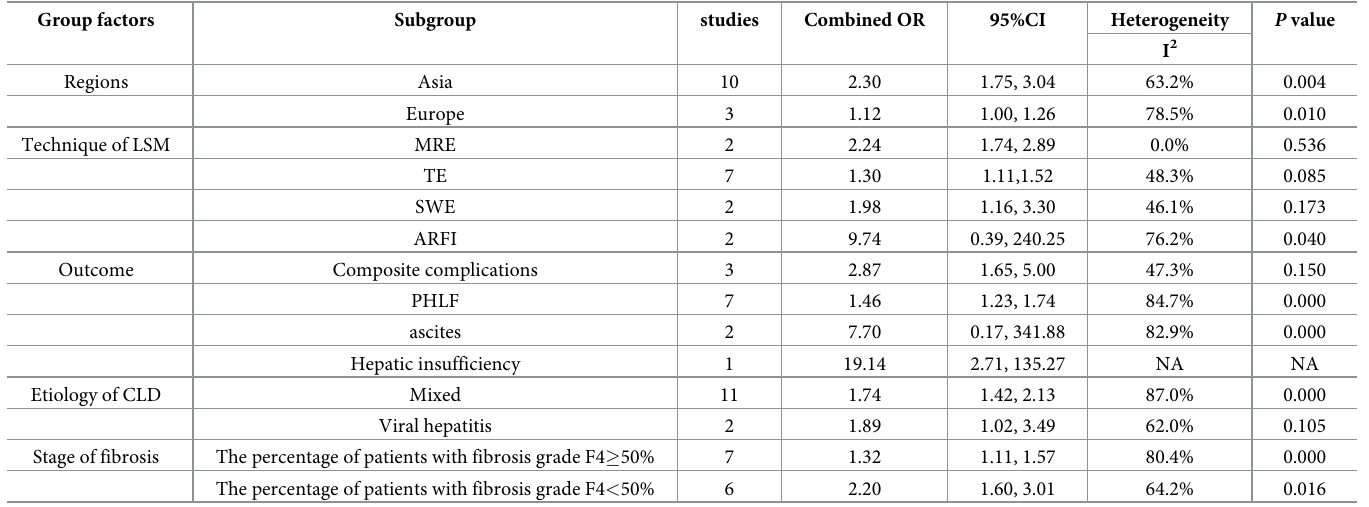
The percentage of patients with fibrosis grade F4 < 50% LSM, liver stiffness measurement; TE, transient elastography; SWE, shear wave elastography; MRE, magnetic resonance elastography; ARFI, acoustic radio force impulse; CLD, chronic liver diseases.